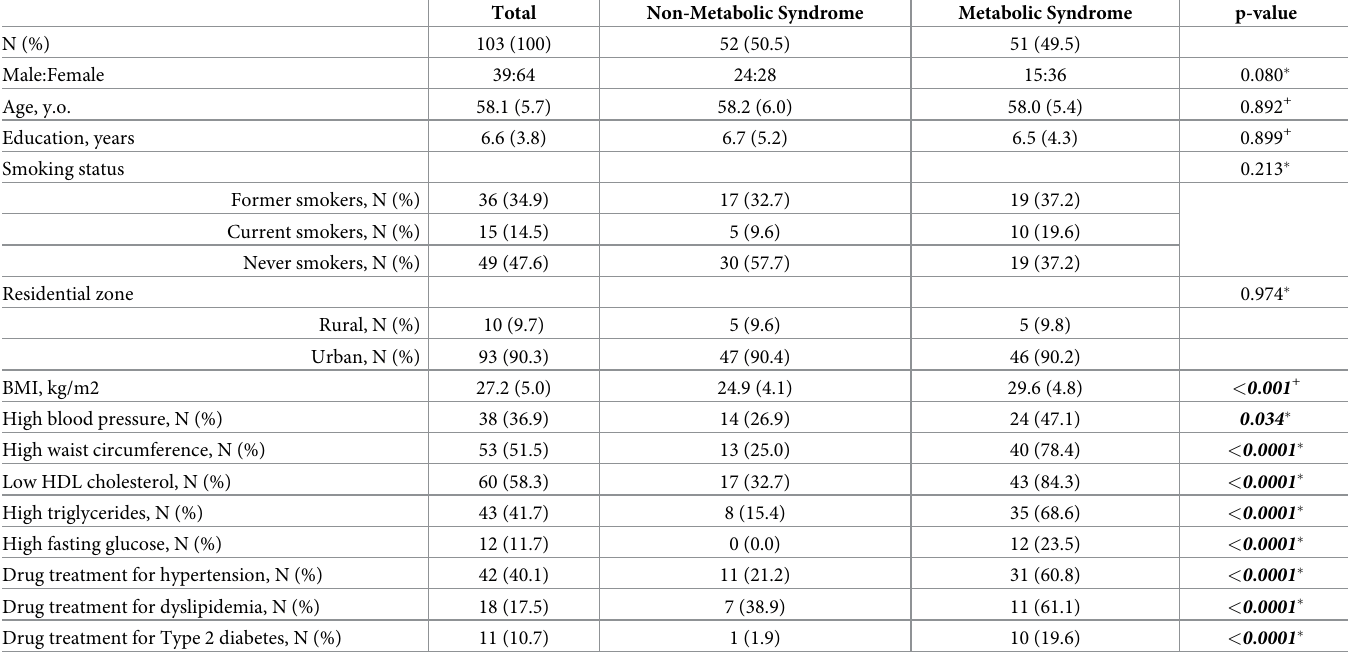
Table 2. Participant characteristics, for total and separated by MetS